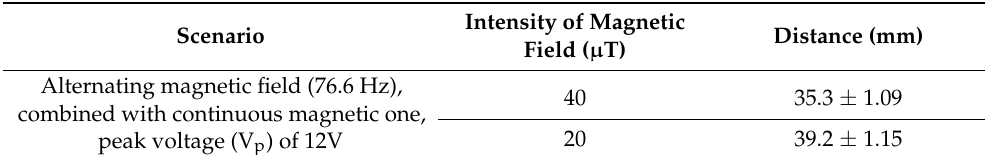
Table 1. Records of magnetic field values for stimulation in the coil by alternating and continuous electrical signal with readings of signal capture distances.